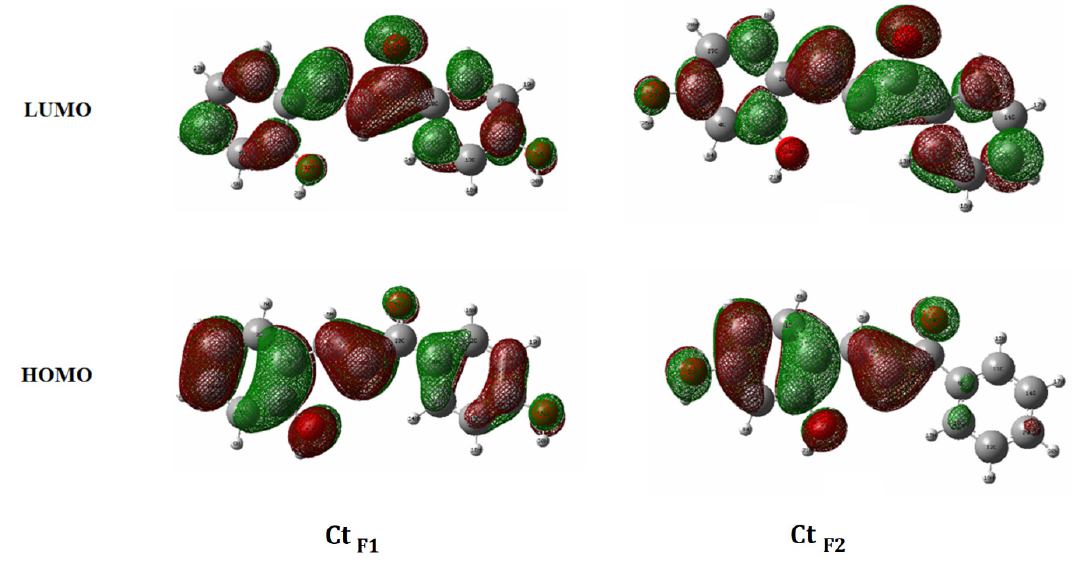
Figure 7. DFT modeling for HOMO and LUMO orbitals of trans -chalcones for F1 and F2 .